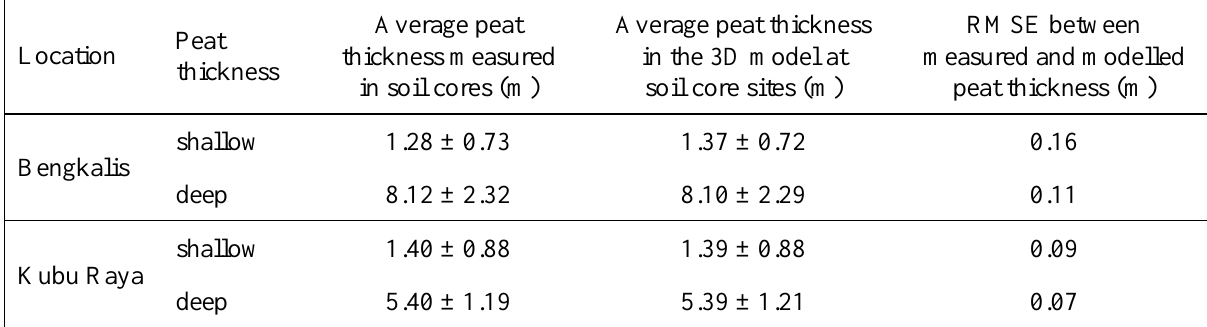
Table A3. Surface fitting error in the 3D peat models.